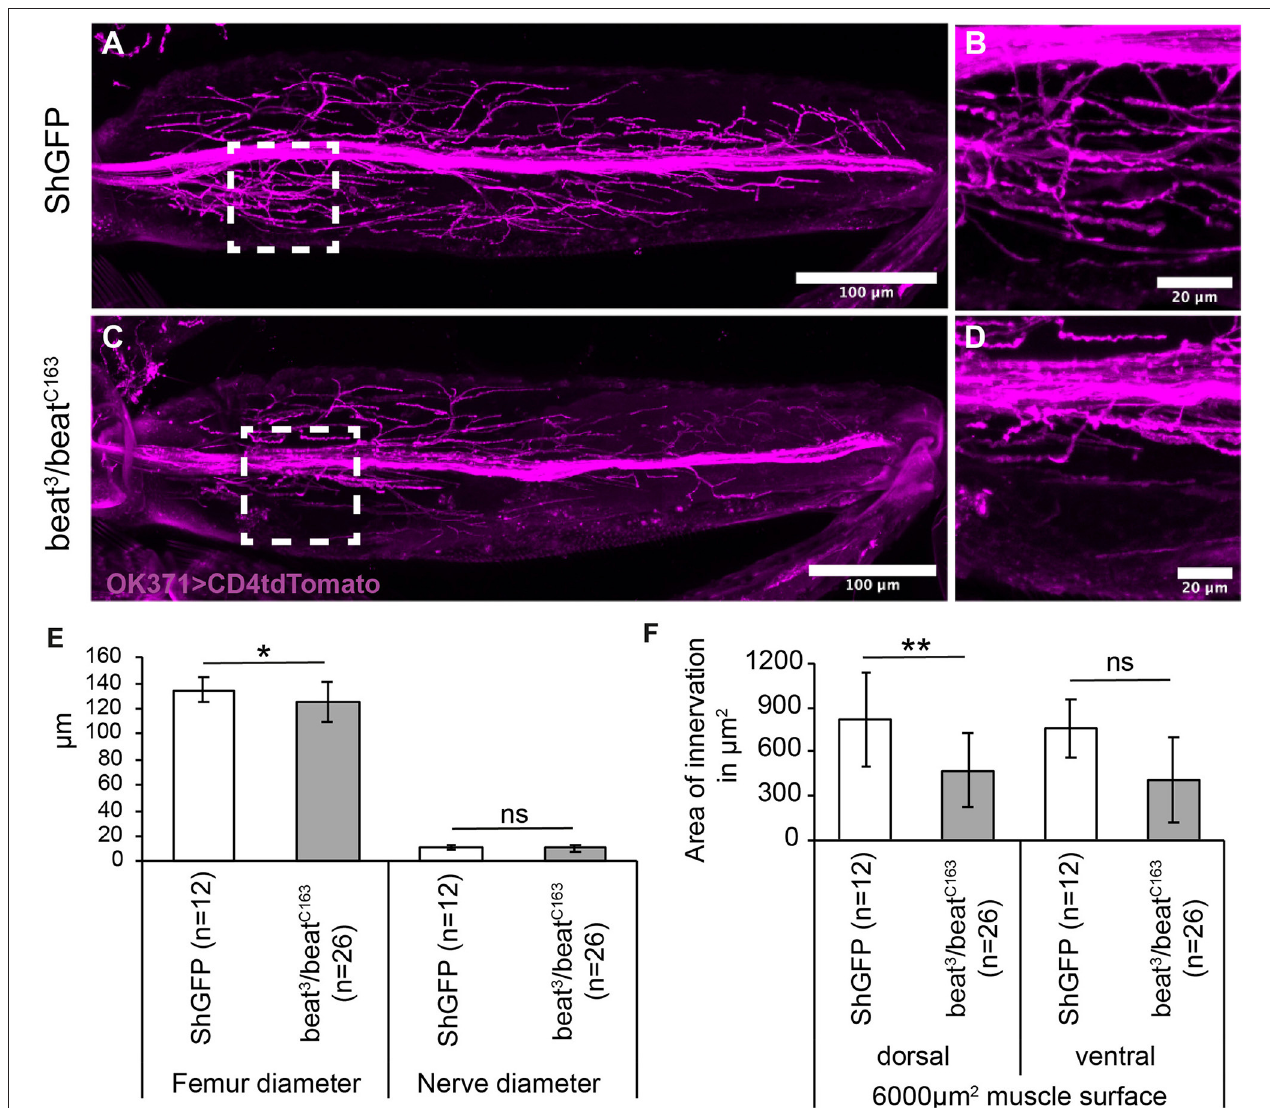
FIGURE 6 | Beat mutant flies show innervation errors of femur muscles. (A–D) Confocal micrographs of motor axon projections in the femur of pharate adults expressing CD4tdTomato (magenta) under control of OK371-Gal4 . (A,B) ShGFP control flies show axons sprouting in the periphery from a main nerve bundle. (C,D) In beat mutants, a subset of defasciculating axons does not reach peripheral muscle regions and choose innervation sites closer to the main nerve bundle. (E,F) Statistical analysis of femur innervation in control and beat mutant flies. The overall femur diameter is slightly decreased in beat mutants (E) , as is the innervation area on the dorsal tilm muscle (F) . White frames mark regions enlarged in new micrographs in B,D . Data are means ± SD and n = number of femurs. Two-tailed Student’s t -test or Mann–Whitney U -test, ** P < 0.01, * P < 0.05, ns, not significant. Genotypes: w;ShGFP; + , w;beat 3 , ShGFP/beat C 163 , ShGFP; + , w;OK371-Gal4, ShGFP/ + ;UAS-CD4tdTomato/ + , w;beat 3 , OK371-Gal4/beat C 163 ;UAS-CD4tdTomato/ + . Scale bars: A,C 100 µ m; B, D 20 µ m.